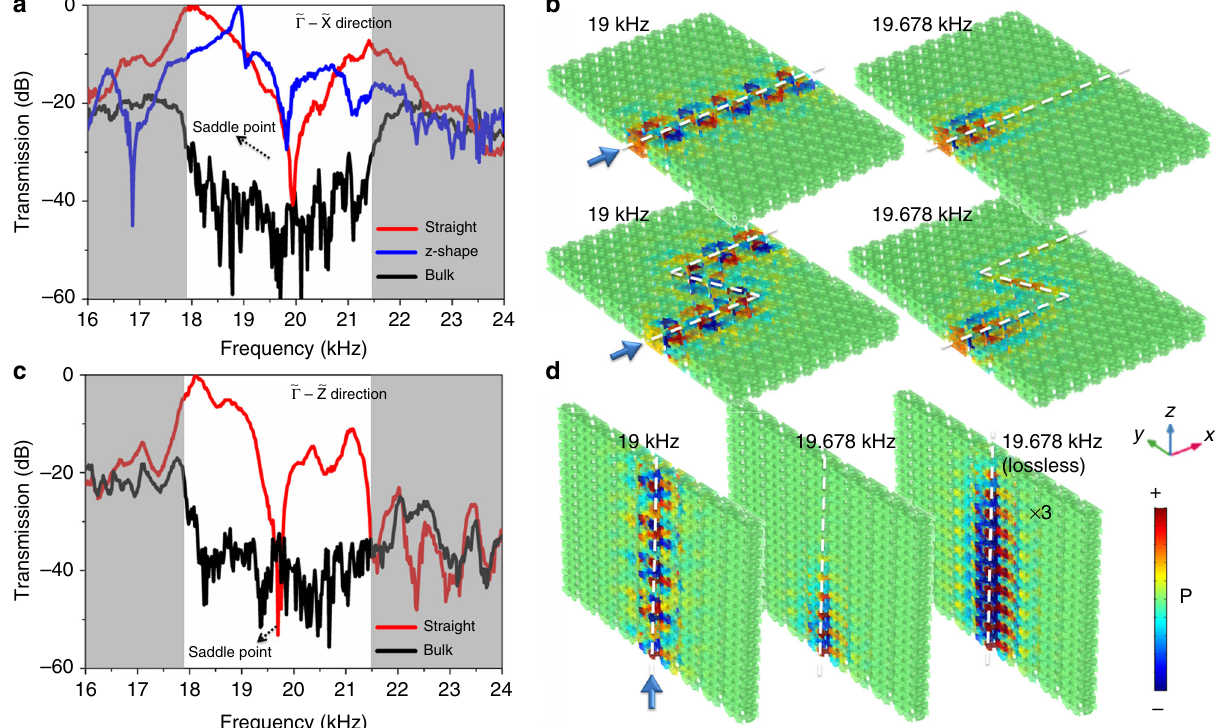
Fig. 3 Backscattering suppressed sound transport. a Experimental transmission spectra along the ~ Γ – ~ X direction, where red, blue and black lines represent the straight, z-shape and bulk conditions, respectively. The shadow regions indicate the bulk pass bands. b Simulated fi eld distributions of the acoustic pressure for both straight and z-shape waveguides. c , d Experimental transmission spectra along the ~ Γ – ~ Z direction and corresponding fi eld simulations. The loss is considered in simulations, except for one case (noted as lossless) for comparison. The white dashed lines indicate the